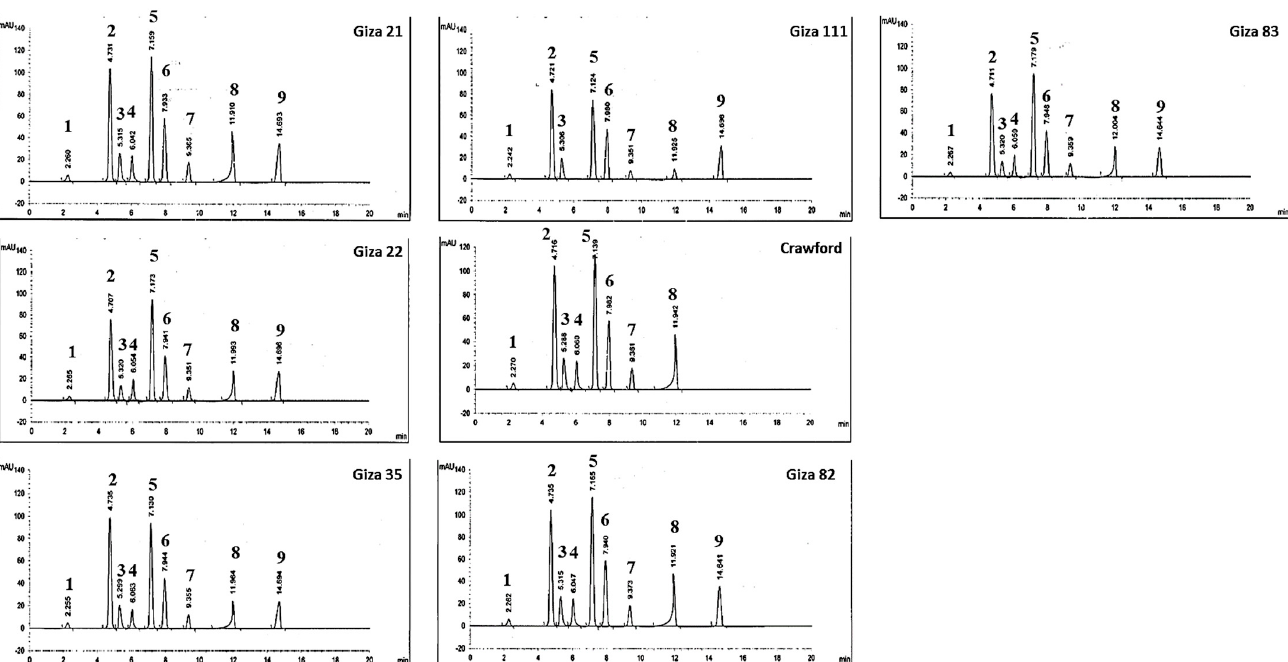
Figure 1. HPLC of major phenolic, flavonoid, and isoflavone compounds (1: syringic, 2: quercetin, 3: gallic acid, 4: benzoic acid, 5: genistein, 6: daidzein, 7: p -coumaric, 8: glycitein, and 9: ferulic acid) in eight soybean cultivar extracts.